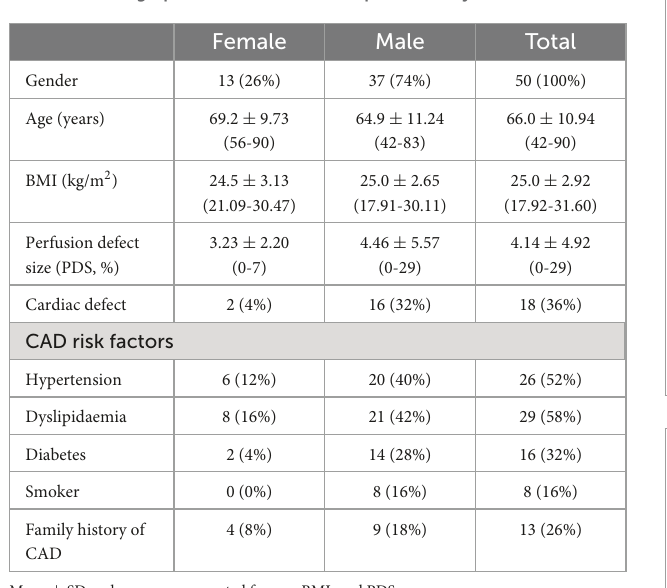
TABLE 1 Demographic information for the patient study.